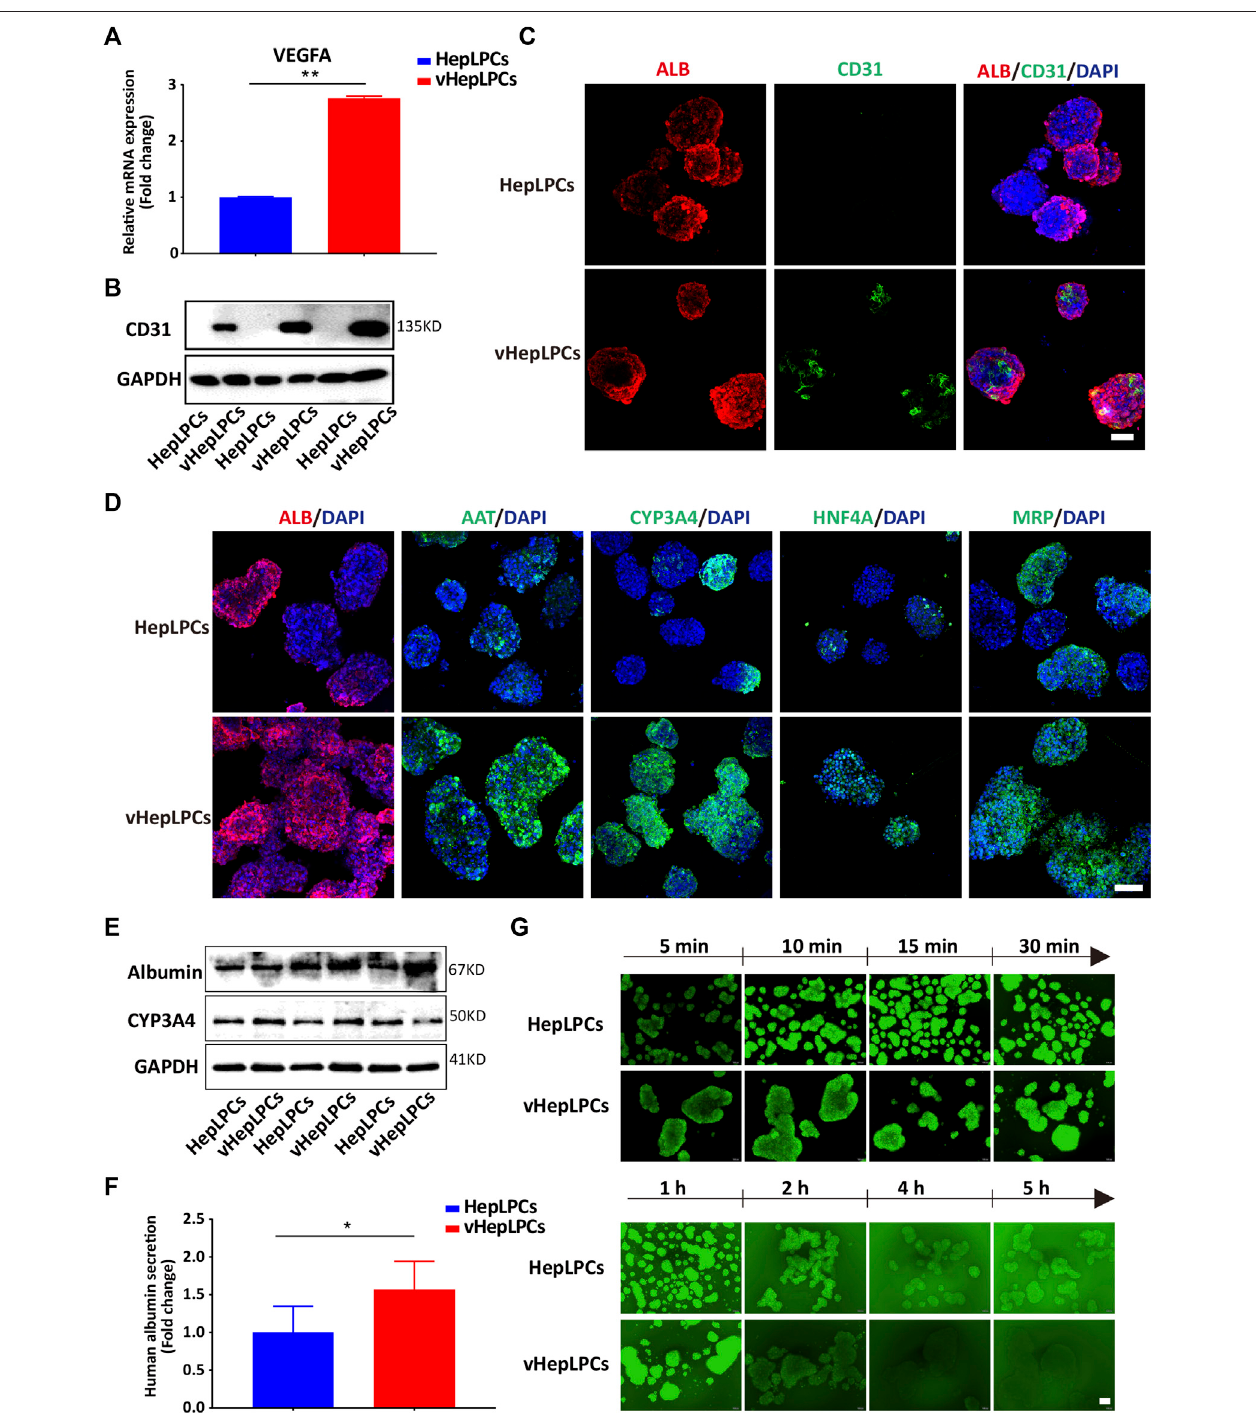
FIGURE 2 | Co-culture of HepLPCs and HUVECs promoted HepLPCs maturation. (A) VEGFA expression was measured by qRT-PCR. Data are normalized to HepLPCs. (B) Western blot analysis of the expression of CD31 ( n (cid:2) 3 per group). (C) The expression of ALB and CD31 in HepLPCs and vHepLPCs was determined by co-immuno fl uorescent staining. Nuclei were counterstained with DAPI. (D) Immuno fl uorescent staining analyses of the expression of mature hepatic markers after co- culture with HUVECs, ALB, AAT, CYP3A4, HNF4A and MRP. Nuclei were counterstained with DAPI. (E) Western blot analysis of the expression of ALB and CYP3A4 in two groups ( n (cid:2) 3 per group). (F) Quantitative analysis of ALB secretion in supernatants. Data are normalized to HepLPCs ( n (cid:2) 3 per group). (G) Time-lapse imaging of microvilli network in HepLPCs and vHepLPCs at 5 min to 5 h of incubation with CDFDA (1 μ M). Fluorescence images show both cell types can transport CDFDA, but vHepLPCs exhibited faster transport ef fi ciency than HepLPCs. Data are presented as means ± SEM. * p < 0.05, ** p < 0.01. Scale bars, 100 µm.